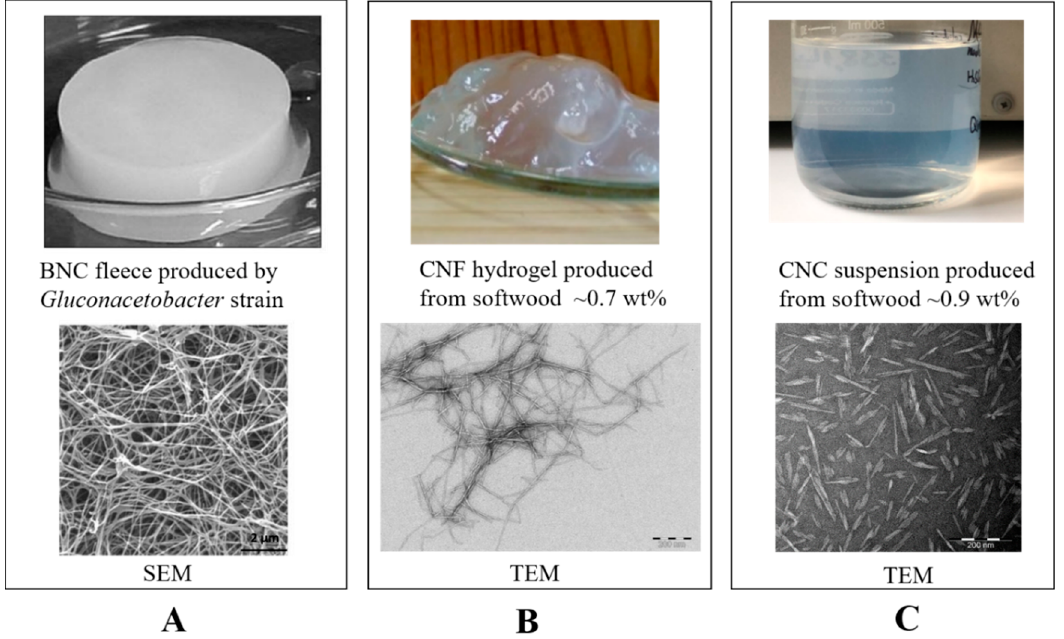
Figure 1. Various nanocellulose products and their microscopic morphology under scanning electron microscopy (SEM) or transmission electron microscopy (TEM) observation: ( A ) BNC (images are reproduced from [10] with the copyright permission from WEILEY-VCH Verlag GmbH & Co.); ( B ) Cellulose nanofibrils (CNFs); ( C ) cellulose nanocrystals (CNCs).